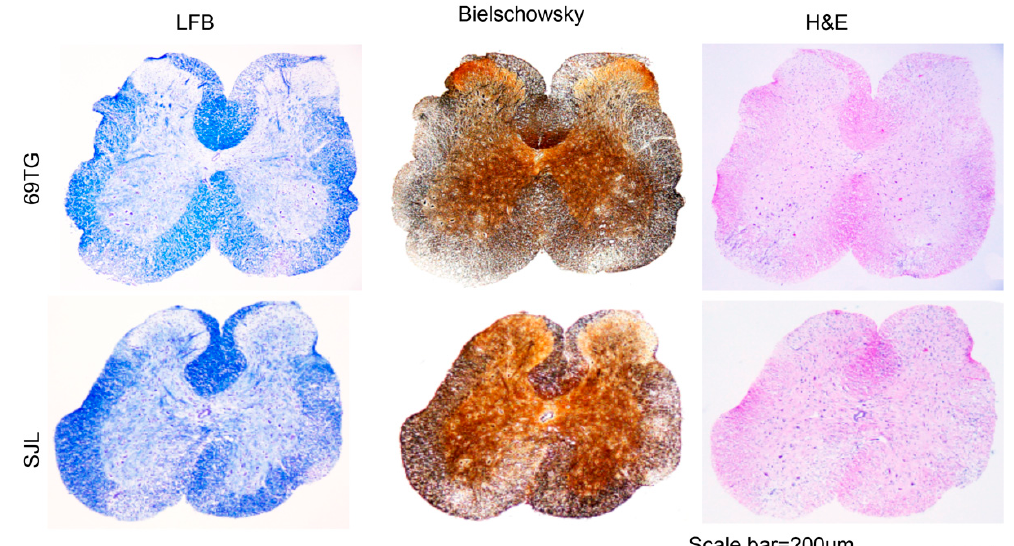
Figure 2. Histology of the spinal cords from TCR-Tg and control mice infected with TMEV. Four different sections of the spinal cords of TCR-Tg and control SJL mice at 65 dpi were stained with Luxol Fast Blue (LFB), Bielschowsky silver staining or H&E. A representative sample is shown. Original magnification of the black scale bar = 200 µm.